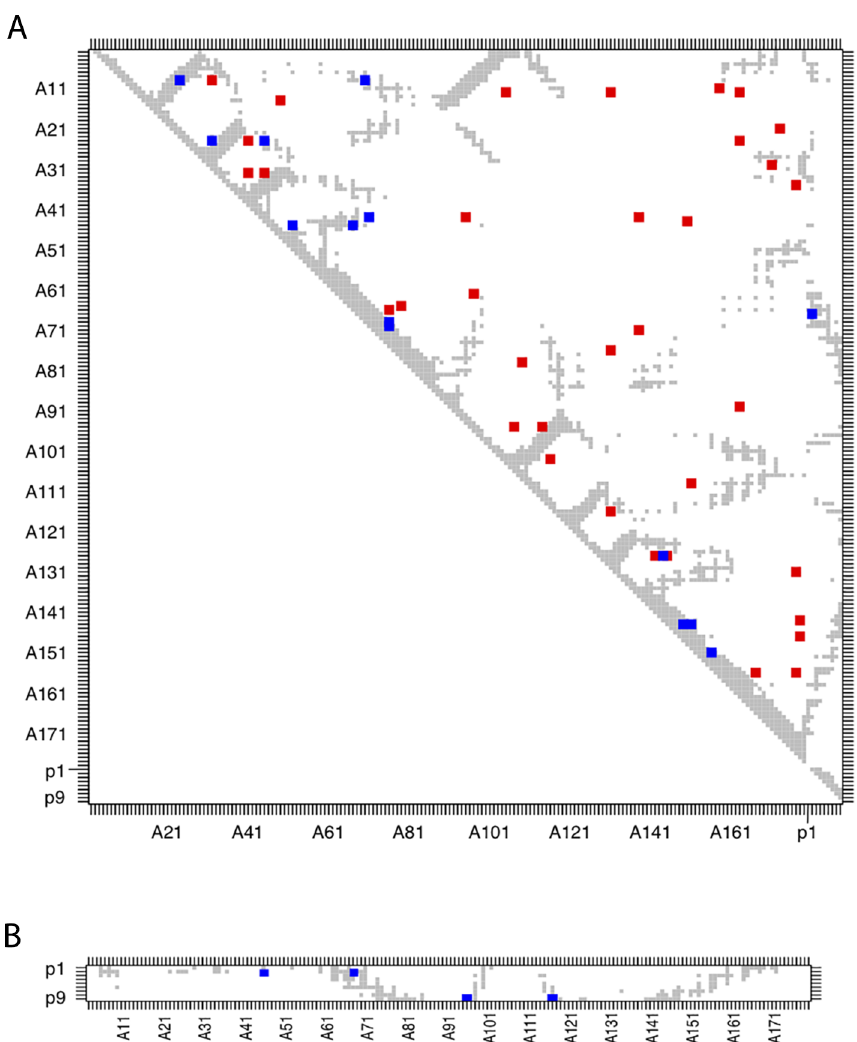
Fig 5. Co-evolution in human MHC-I sequences and their experimentally determined ligands. Contact map based on HLA-A02:01 structure (PDB: 2BNR, pairs of residues at distance < 8 Å are shown in grey) summarizing DCApeptides predictions for the alignment of 156 human MHC-I molecules and their ligands. Chain A stands for the MHC-I sequence and chain P (P1-P9) for the ligands. Blue squares represent structurally close pairs of sites predicted by DCApeptides and red squares represent structurally distant pairs of sites predicted by DCApeptides. A. Co- evolution signal using the full alignment of MHC-I and their ligands (top 44 pairs). B. Inter-molecular co-evolution signal between MHC-I and their ligands (top 4